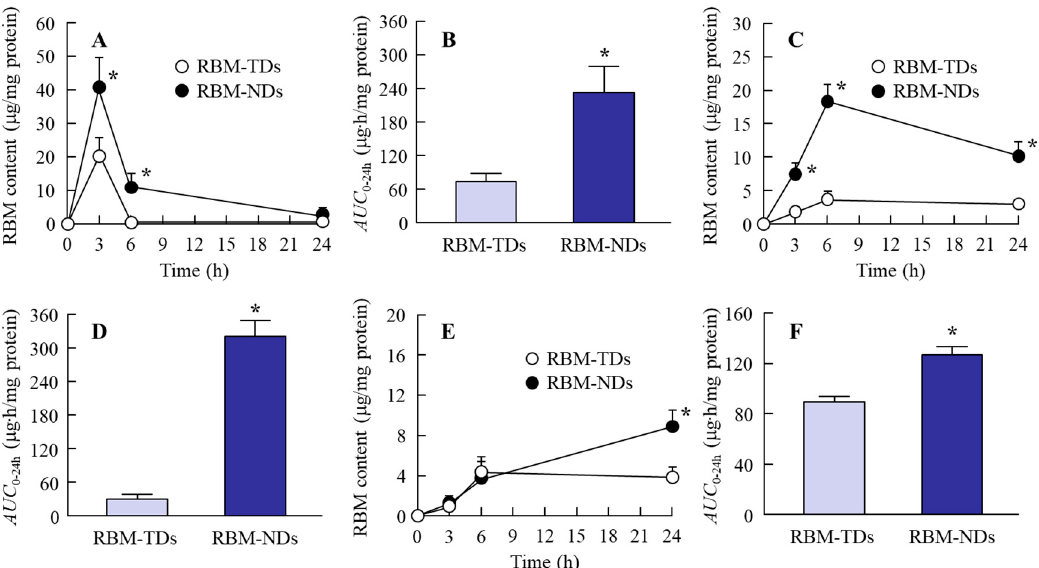
Figure 4. Changes in RBM contents in the stomach, jejunum, and ileum of rats orally administered RBM-TDs and RBM-NDs. RBM contents ( A ) and areas under the drug concentration-time curves (AUC) 0–24h ( B ) in the stomach. RBM contents ( C ) and AUC 0–24h ( D ) in the jejunum. RBM contents ( E ) and AUC 0–24h ( F ) in the ileum. RBM-TDs: RBM-TDs-administered rats; RBM-NDs: RBM-NDs-administered rats. n = 6–9, * p > 0.05 vs. RBM-TDs. In the stomach, jejunum, and ileum, the RBM